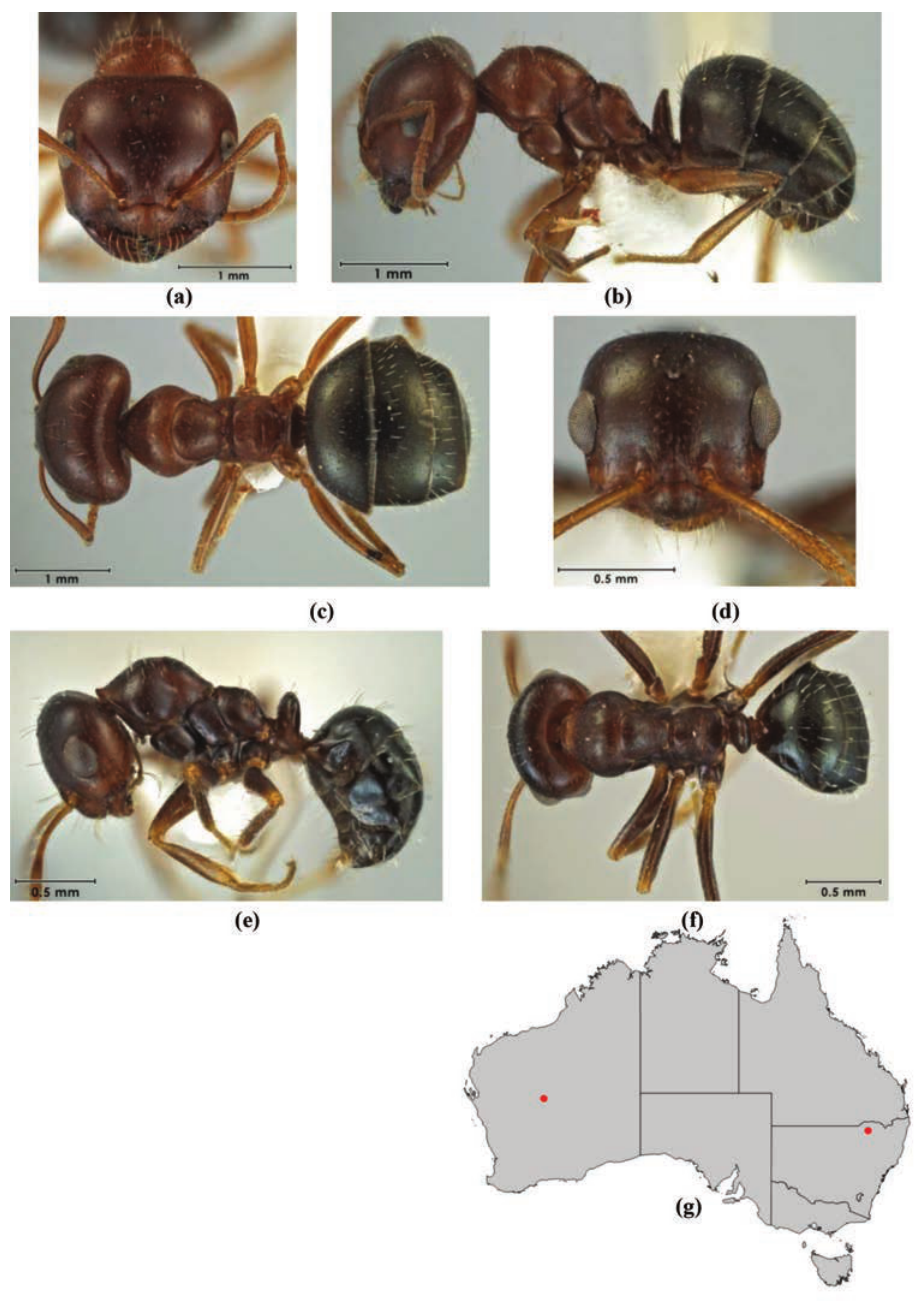
Figure 64. Melophorus major Forel: major worker (CASENT0905126) (MSNG) frons ( a ), profile ( b ) and dorsum ( c ); minor worker (NHRS-HEVA 000003949) (NHRS) frons ( d ), profile ( e ) and dorsum ( f ); distribution map for the species ( g